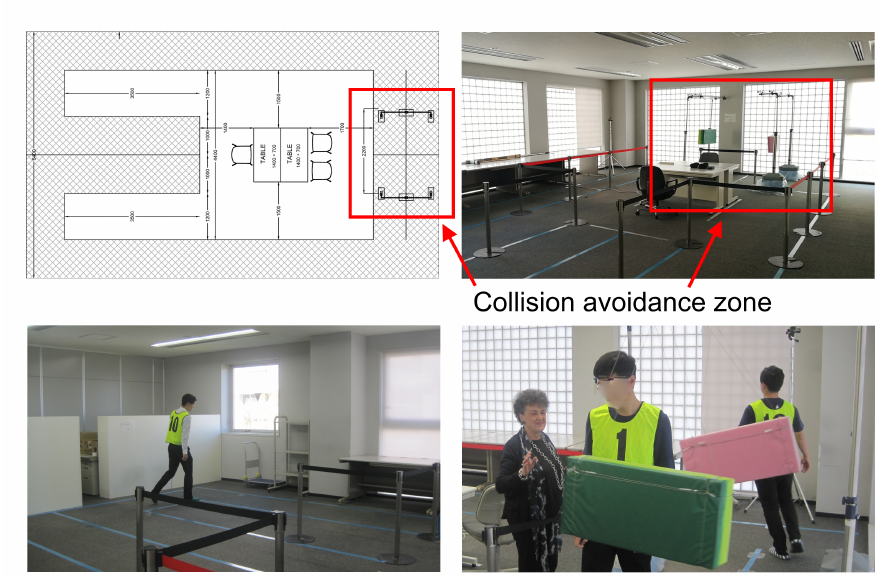
Figure 2. Controlled experiment. Top left: the plant of the laboratory, where the path chosen for the walking activities is depicted. A red rectangle identifies the collision avoidance zone in the two images of the first raw. In this zone, two obstacles are moved by one of the experimenters and the two subjects have to avoid the collision (figure bottom right). During the rest of the path, subjects walk with their own natural